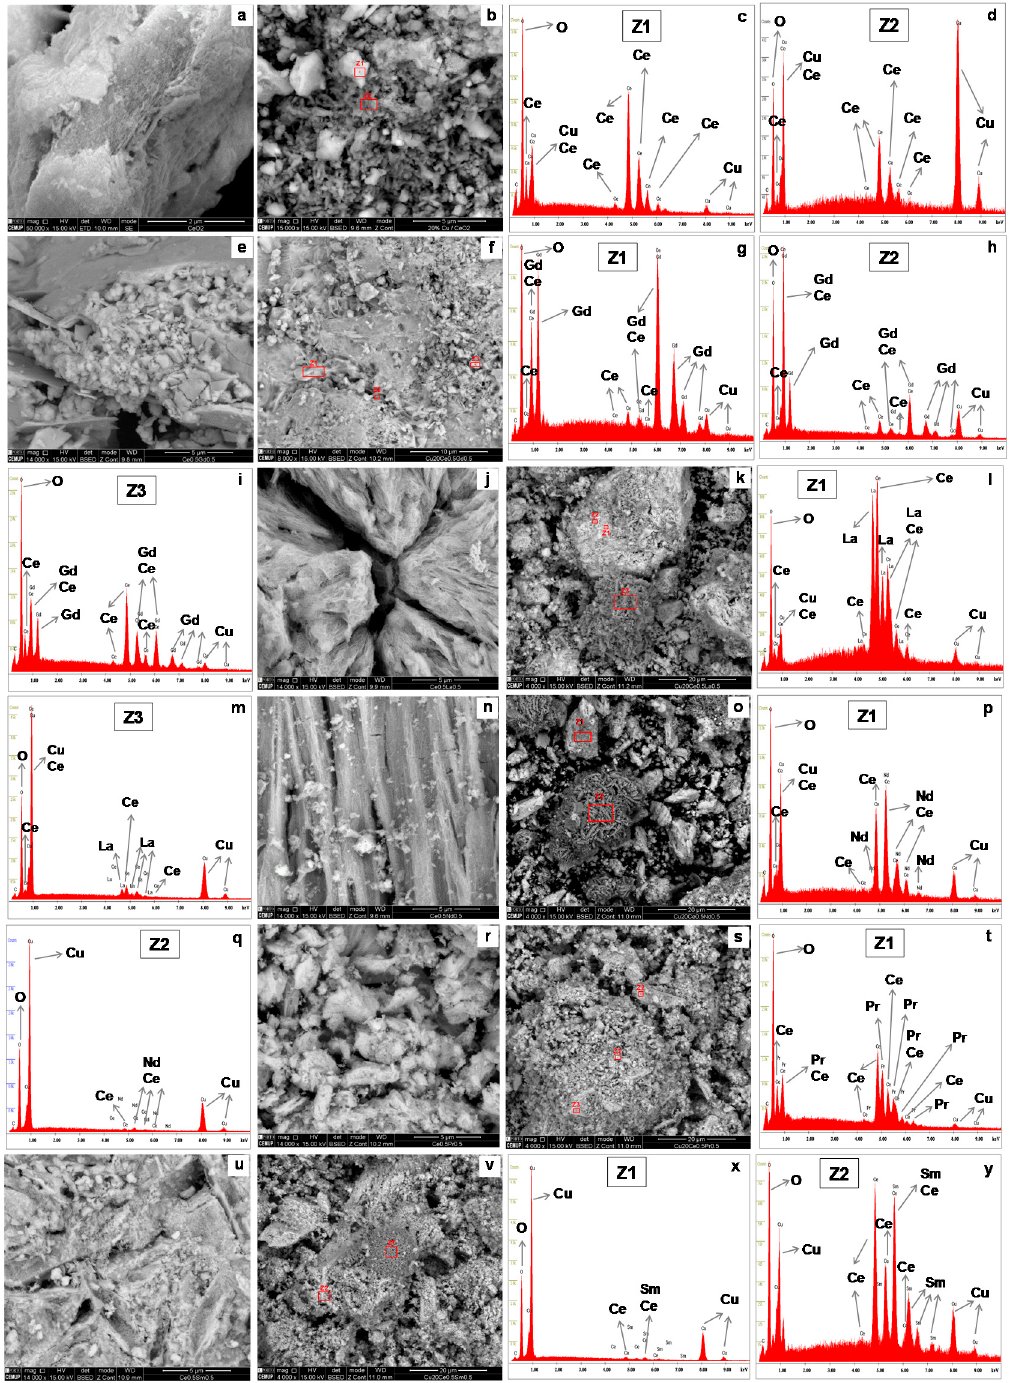
Figure 3. SEM images of CeO 2 ( a ); Cu/CeO 2 ( b ) and respective EDS spectra of zones marked as Z1 ( c ) and Z2 ( d ); Ce-Gd ( e ); Cu/Ce-Gd ( f ) and respective EDS spectra of zones marked as Z1 ( g ), Z2 ( h ) and Z3 ( i ); Ce-La ( j ); Cu/Ce-La ( k ) and respective EDS spectra of zones marked as Z1 ( l ) and Z3 ( m ); Ce-Nd ( n ); Cu/Ce-Nd ( o ) and respective EDS spectra of zones marked as Z1 ( p ) and Z2 ( q ); Ce-Pr ( r ); Cu/Ce-Pr ( s ) and respective EDS spectra of zone marked as Z1 ( t ); Ce-Sm ( u ); Cu/Ce-Sm ( v ) and respective EDS spectra of zones marked as Z1 ( x ) and Z2 ( y ).